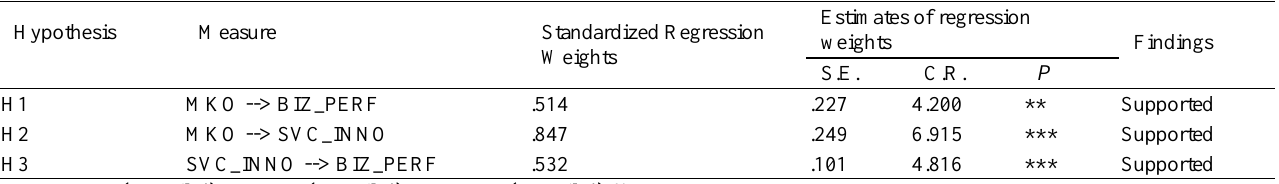
Table 3: Standardized regression and estimates of regression weights Hypothesis